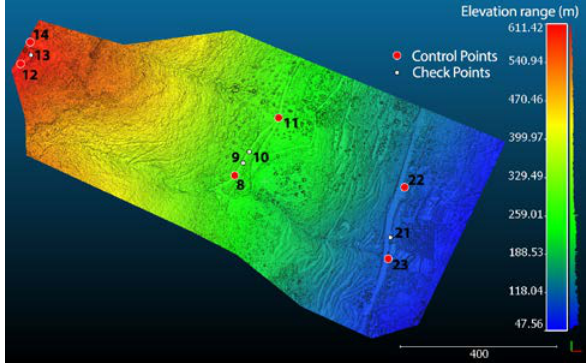
Figure 7. Scenario (a) – 6 GCPs distributed at the top, middle and bottom of the target slope (units in m)